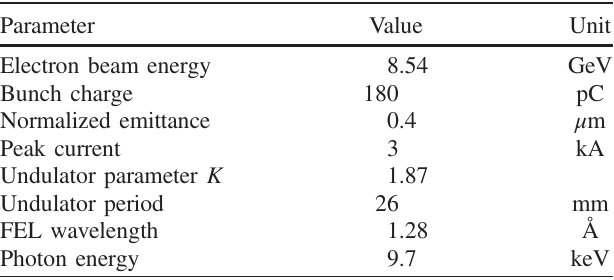
TABLE I. Main parameters measured at PAL-XFEL.